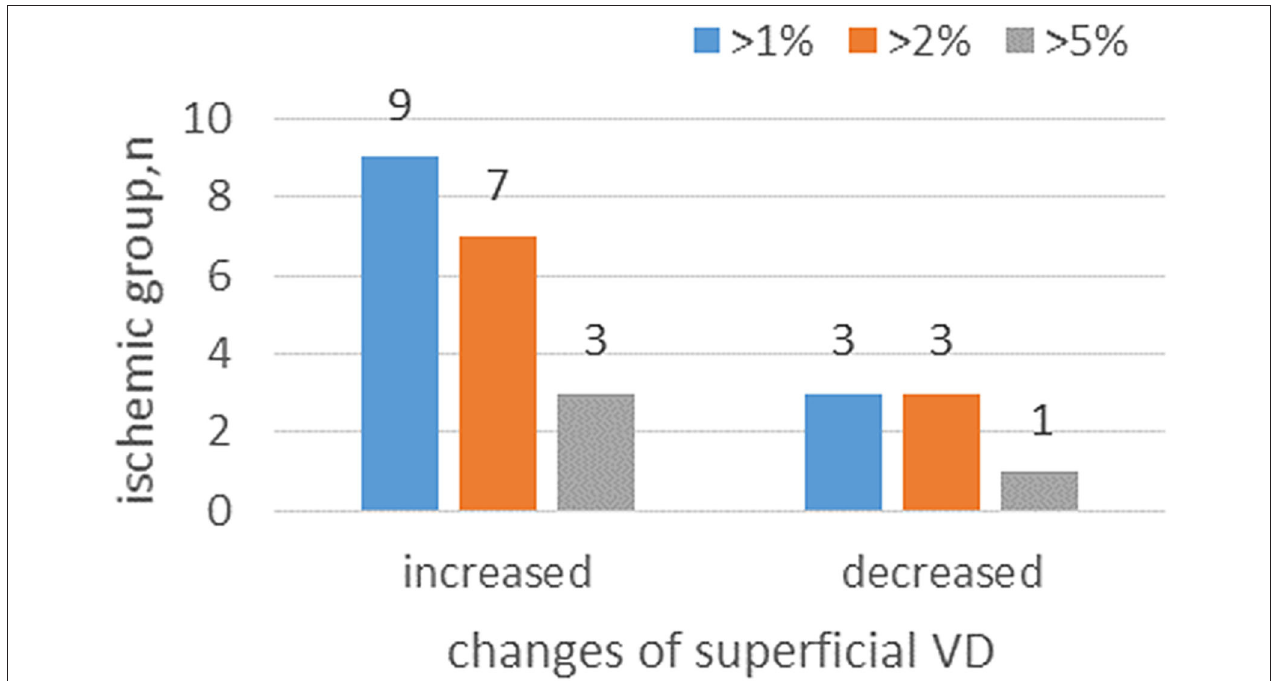
FIGURE 3 | The distribution of the number of patients with VD